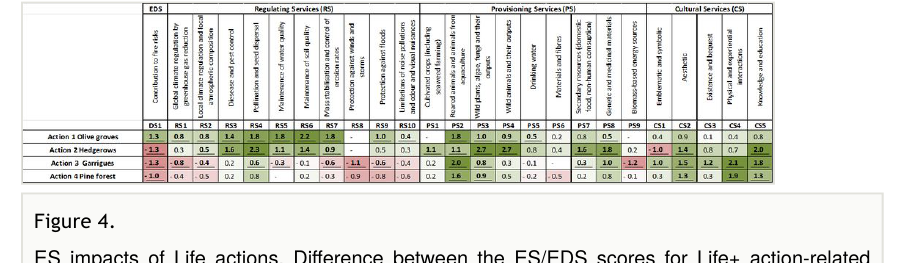
Figure 4. ES impacts of Life actions. Di ff erence between the ES/EDS scores for Life+ action-related ecosystem types (before–after). Bold underlined values indicate signi fi cant di ff erences in scores (paired t -tests, p<0.05). ES = ecosystem service ; EDS = Ecosystem